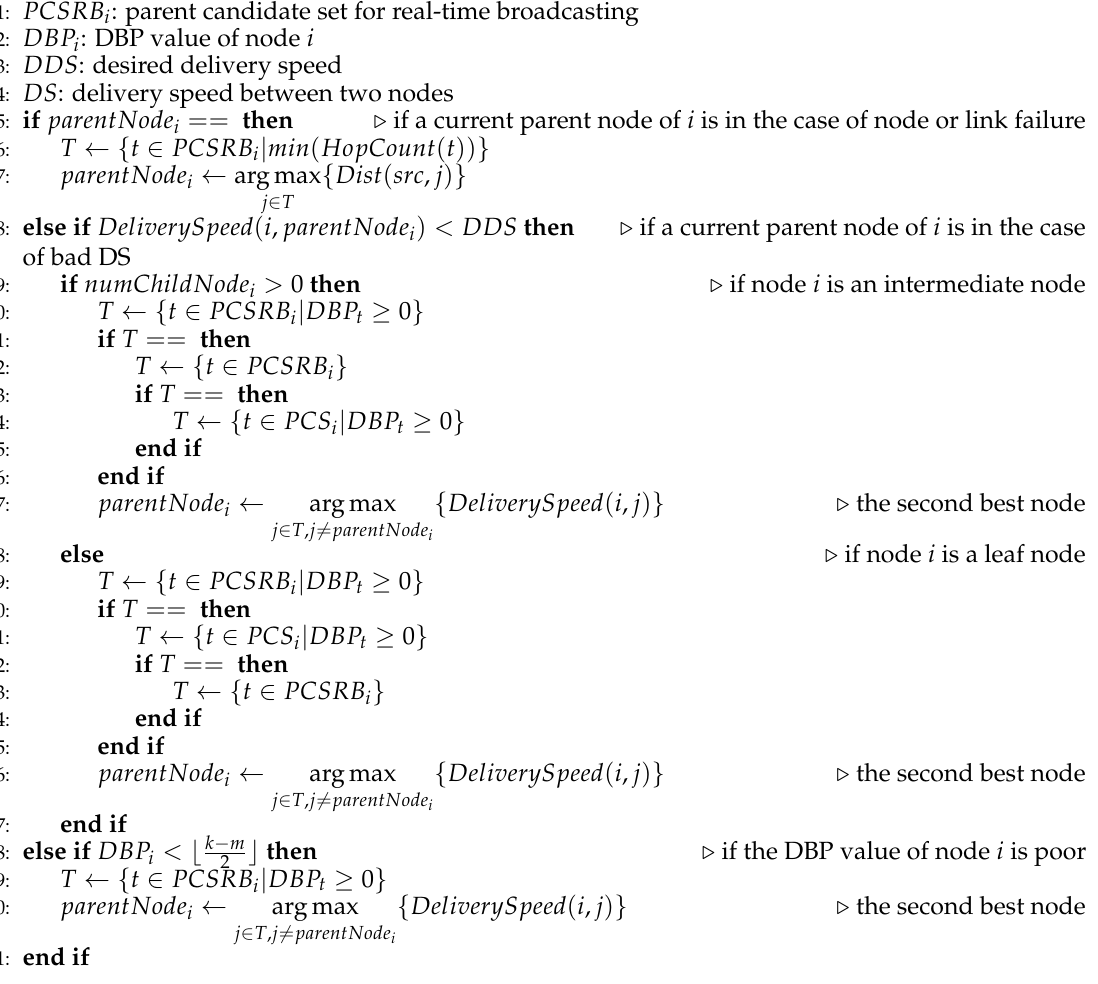
Algorithm 2 Real-time failure